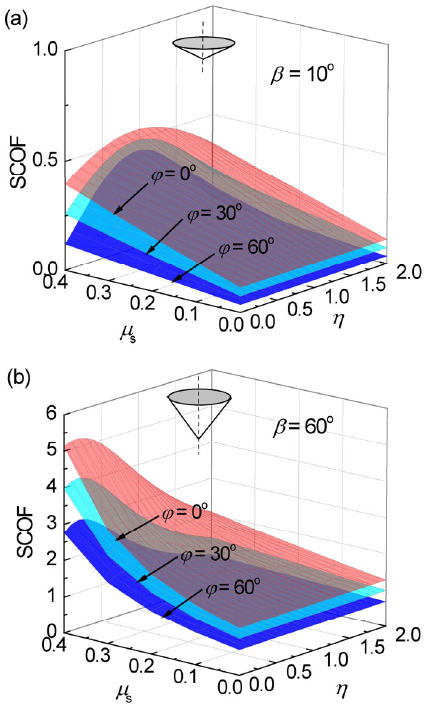
Fig. 9 Effect of the elastic recovery on SCOFs: (a)  = 10° and (b)  = 60°. Fig. 10 SCOFs as a function of 